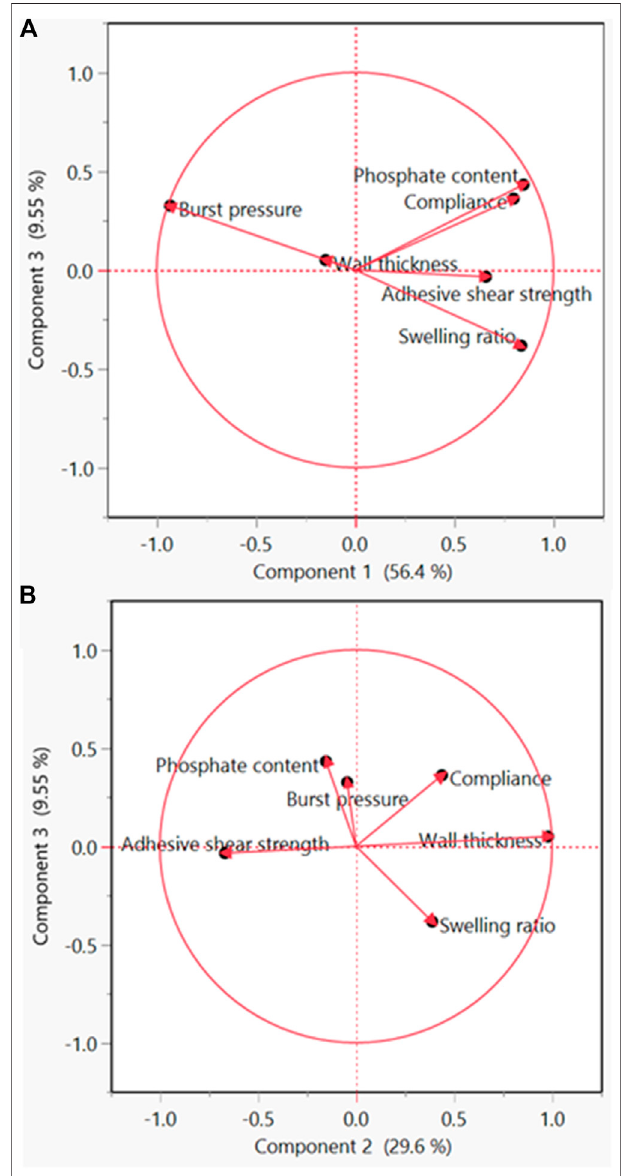
FIGURE 8 | Principle component analysis (PCA) for the identi fi cation of signi fi cant components. (A) PCA plot of component 1 vs. component 3. (B) PCA plot of component 2 vs. component